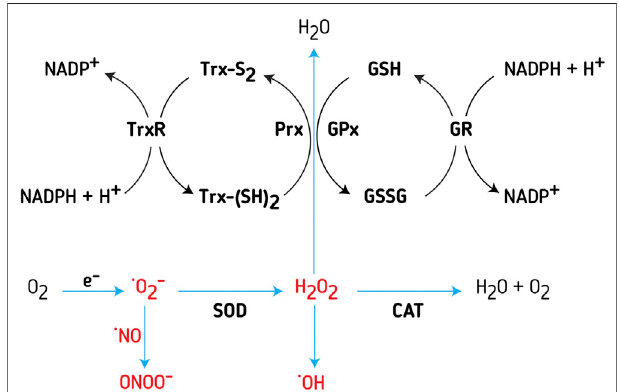
FIGURE 2 | Redox systems - Trx and GSH systems, are important regulators of intracellular RONS concentration . Major sources of RONS inside the cell are the electron transport chain (ETC) in mitochondria and NADPH oxidases (NOX). Superoxide anion (O 2 − ) is the main free-radical deriving fromETC;duetolackofstability,themoleculeisrelativelyeasilytransmutedto hydrogen peroxide (H 2 O 2 ) or peroxynitrite (ONOO − ). Superoxide dismutase (SOD) is an enzyme catalyzing the transmutation of 2O − to H 2 O 2 . Further on, H 2 O 2 is neutralized by several different enzymes and enzyme systems. The most potent is peroxiredoxins (Prx), a cysteine-dependent peroxidase that reacts with H 2 O 2 . Thioredoxin (Trx) reduces Prx, while thioredoxin reductase (TrxR) reduces oxidized Trx, with NADPH as an electron donor. Glutathione peroxidase (GPx) uses reduced glutathione (GSH) for neutralizing hydrogen peroxide. In turn, glutathione reductase (GR) reduces oxidized glutathione (GSSG), with NADPH as an electron donor. Another enzyme, involved in the regulation of H 2 O 2 concentration, found mainly in peroxisomes and cytosol, is catalase